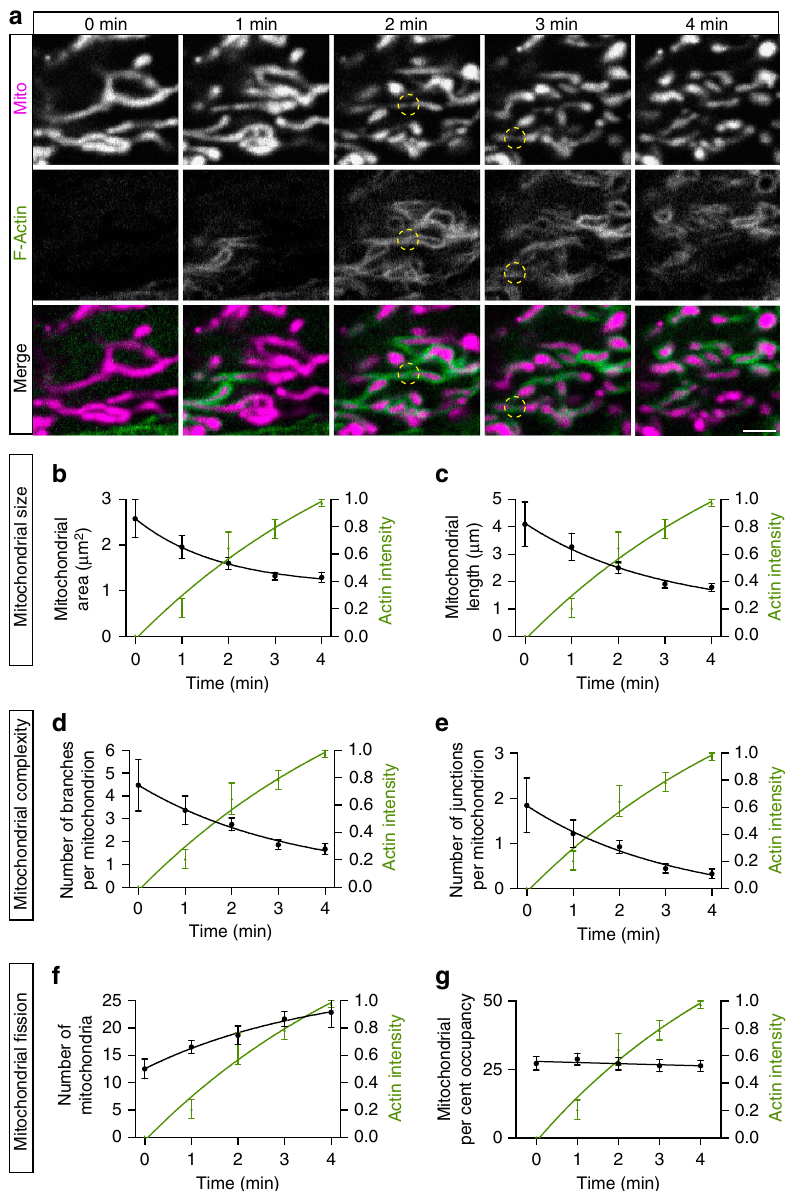
Figure 4 | The mitochondrial network fragments in regions of focal actin assembly. ( a ) Confocal time series of F-actin (LifeAct-GFP) cycling onto elongated, tubular mitochondria (Mito-DsRed2) in a HeLa cell. Over 4min, actin-positive mitochondria become increasingly fragmented. Yellow circles indicate sites of mitochondrial constriction. ( b , c ) Mitochondrial area and length decrease as actin intensity increases within a defined ROI (see Methods for details). ( d , e ) Actin recruitment to mitochondria is linked to changes in mitochondrial shape complexity, including decreased branches and junction points per mitochondrion. ( f , g ) Actin cycling onto mitochondria is associated with increased mitochondrial number, but no change in the overall mitochondrial per cent occupancy within the fixed ROI. Values represent mean ± s.e.m. Scale bar, 2.5 m m ( a ). Sample size: ( b – g ) 6 cells; n ¼ 3 independent